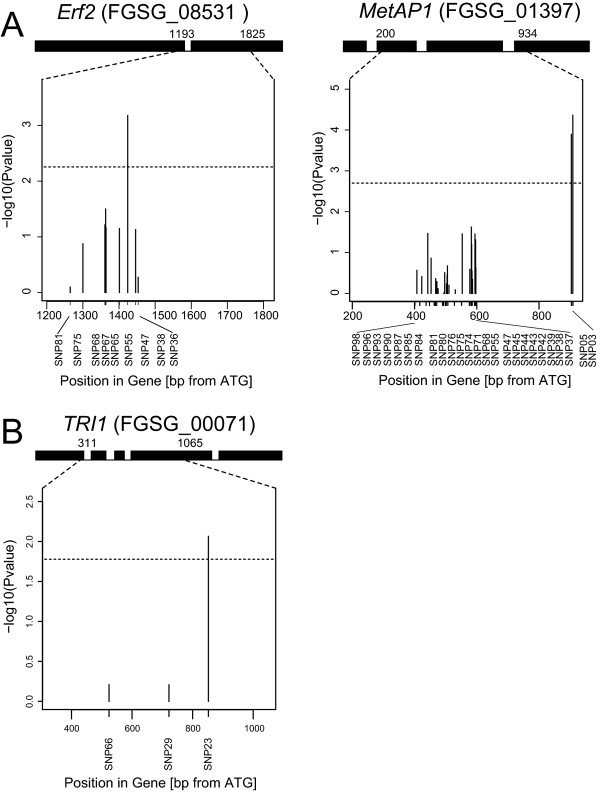
Significant associations in the candidate genes. (A) Erf2 and MetAp1 for mean FHB rating and (B) TRI1 for DON content. The dashed horizontal line indicates the threshold (Bonferroni-corrected P < 0.05).